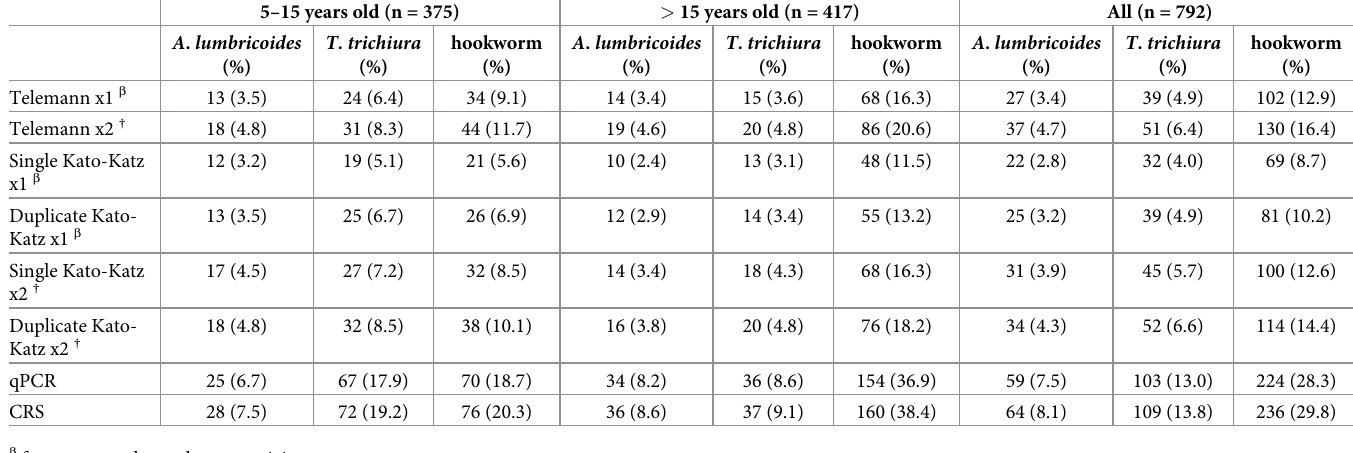
Table 2. Number of participants infected by each soil-transmitted helminth detected by Telemann in one or two stool samples, single and duplicate Kato-Katz in one stool sample, single and duplicate Kato-Katz in two stool samples, multiplex qPCR and by a composite reference standard (CRS, positive for at least one diag- nostic technique) per each age group.